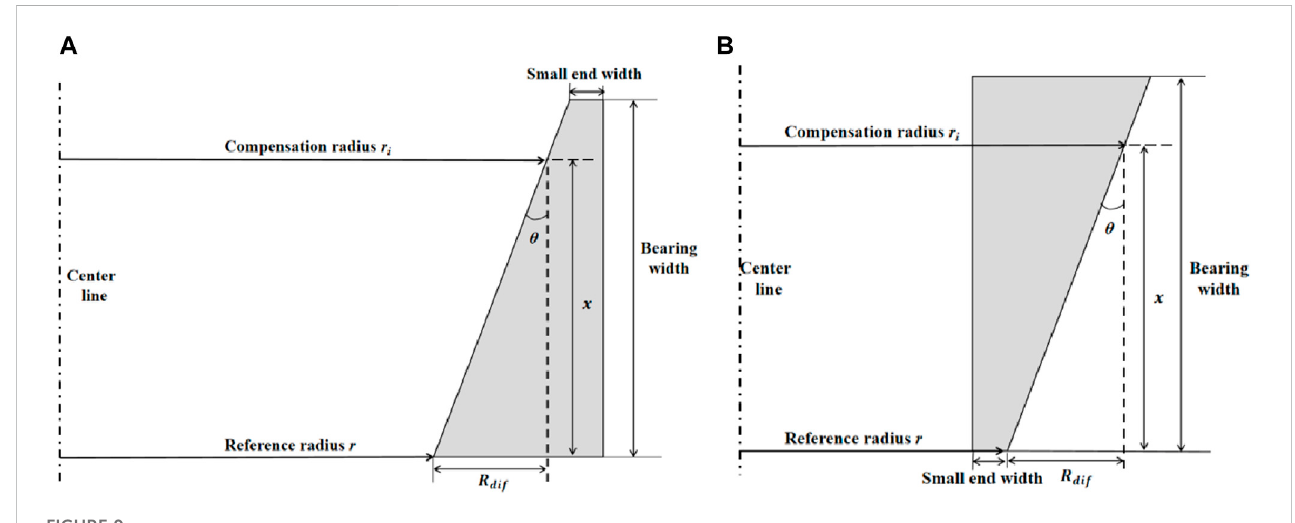
FIGURE 9 (A) Section diagram of the outer bearing ring (B) Section diagram of the inner bearing